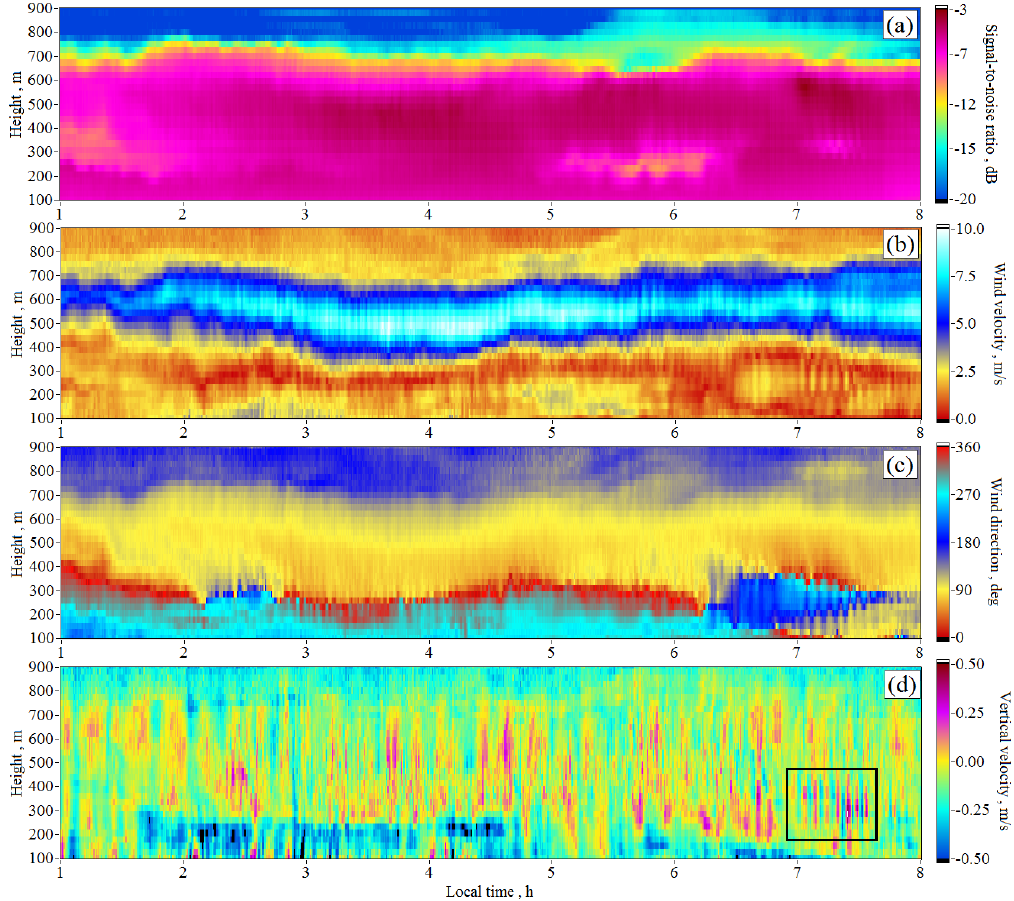
Figure 7. Heights and time distributions of the signal-to-noise ratio (SNR) ( a ), wind velocity ( b ), wind direction angle ( c ), and vertical component of the wind velocity vector ( d ), as obtained from measurements by the StreamLine lidar at the Lake Baikal coast on 24 August